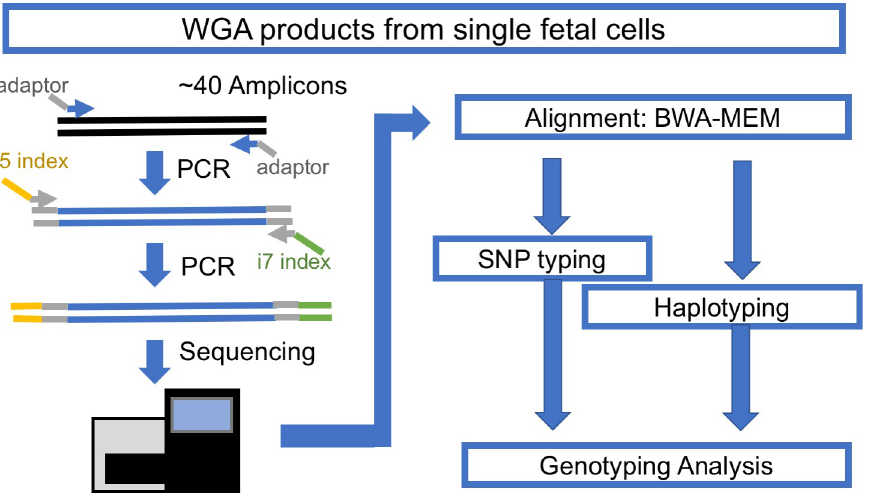
Fig 1. The workflow for amplicon-based